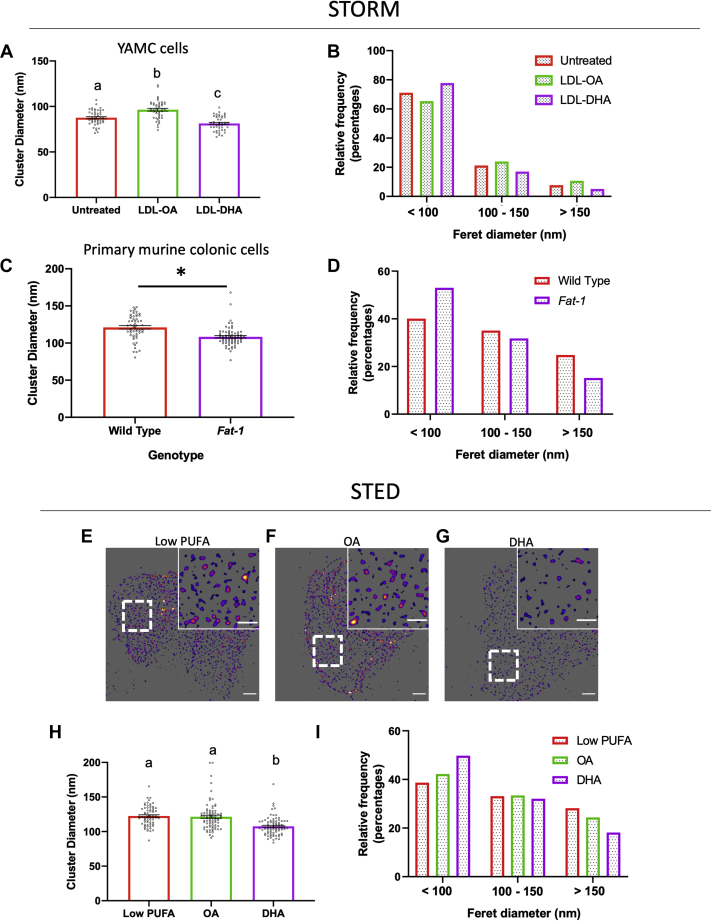
DHA reduces EGFR nanoclustering. YAMC cells were incubated with the indicated treatments (50 μM) for 24 h prior to fixation and subsequent labeling with EGF-Alexa647 for STORM imaging. A: Quantitative analysis of EGFR cluster diameter and (B) relative cluster size in YAMC cells. Data are presented as (A) mean ± SE of average EGFR cluster diameter per FOV and (B) individual cluster distribution. Number of FOVs examined per treatment, untreated = 46, LDL-OA = 46, LDL-DHA = 46, and individual clusters, untreated = 4,824, LDL-OA = 8,305, LDL-DHA = 2,921, from four wells per group from two independent experiments. C: Quantitative analysis of EGFR cluster diameter and (D) relative cluster size in isolated primary murine colonic cells. Data are presented as (C) mean ± SE of average EGFR cluster diameter per FOV, and (D) individual cluster size distribution. Number of FOVs examined per group, wild type = 55 and Fat-1 = 69, and individual clusters, wild type = 4,742 and Fat-1 = 3,872, from 3 or 4 mice, respectively. Adult Drosophila were placed on control (PUFA Free) or OA- or DHA-enriched diets for 5 days at 18°C (permissive temperature) before switching to 29°C for 2 days to induce chimeric human EGFR expression in gut esgG4 cells. E–G: Representative processed STED images from indicated diet. Scale bar, 1 μm and 500 nm. H: Quantitative analysis of EGFR cluster diameter and (I) relative frequency in Drosophila gut esgG4 cells. Data are presented as (H) mean ± SE of average EGFR cluster diameter per FOV, and (I) individual cluster size distribution. Number of FOVs examined per group, Low PUFA = 68, OA = 80, and DHA = 82, and individual clusters, Low PUFA = 51,442, OA = 56,471, and DHA = 35,103, from three independent experiments. Unless otherwise indicated, statistical significance between groups as indicated by uncommon letters (P < 0.001) was analyzed using one-way ANOVA and uncorrected Fisher's LSD tests.